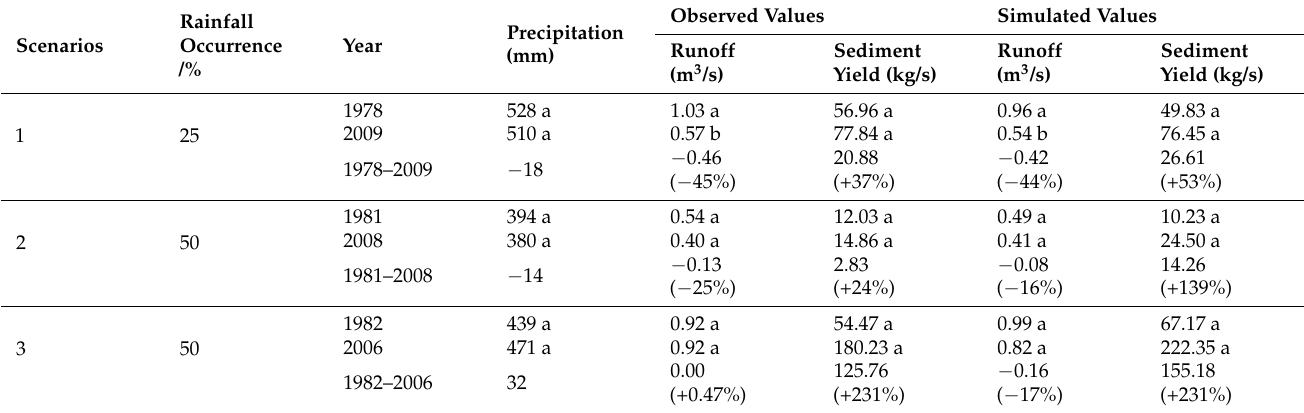
Table 4. Rainfall characteristics and observed values of three hypothetical scenarios with similar ( p > 0.05) annual precipitation but different land